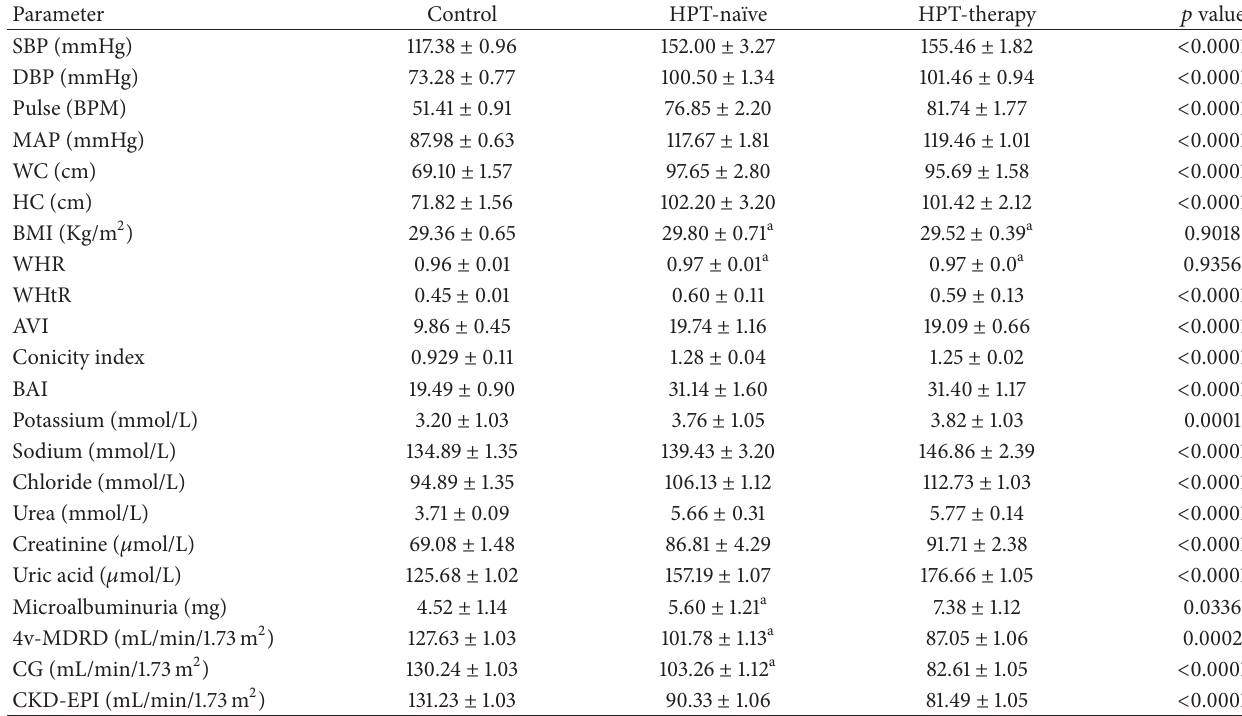
Table 3: Haemodynamic, anthropometric, serum biochemical kidney profile and estimated glomerular filtration rate of the study population stratified by hypertension